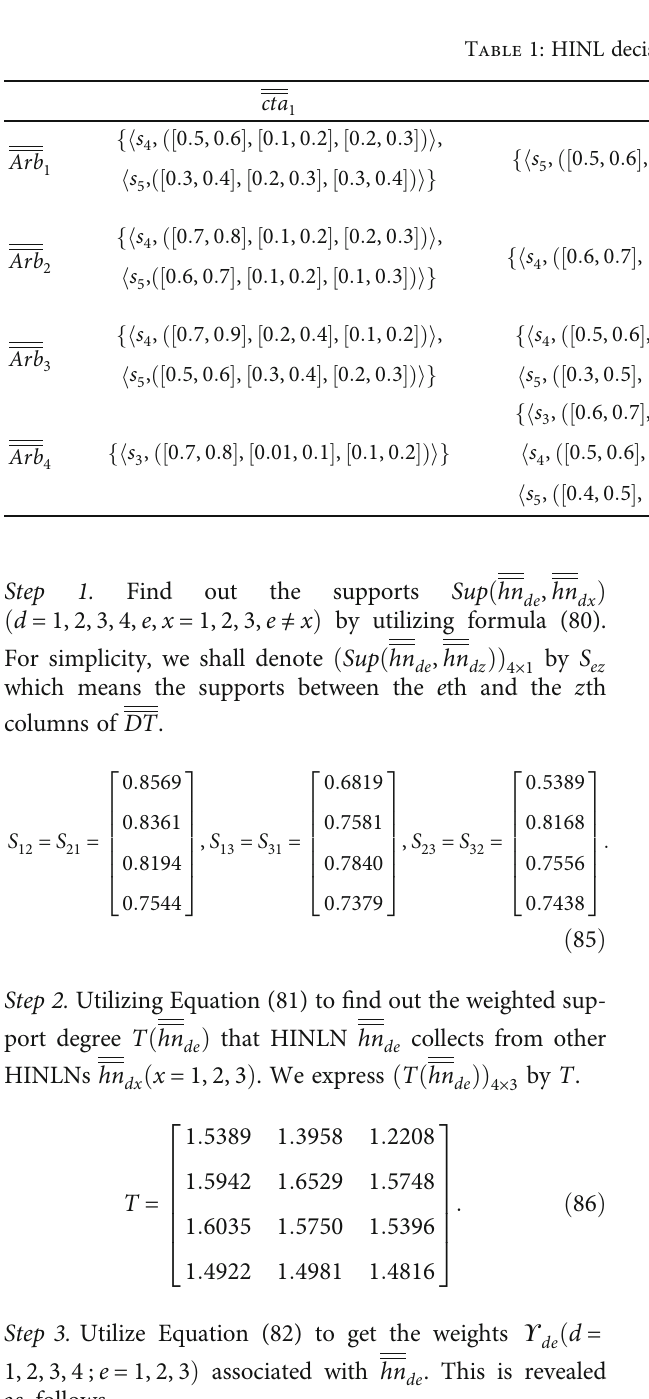
Table 1: HINL decision matrix DT .